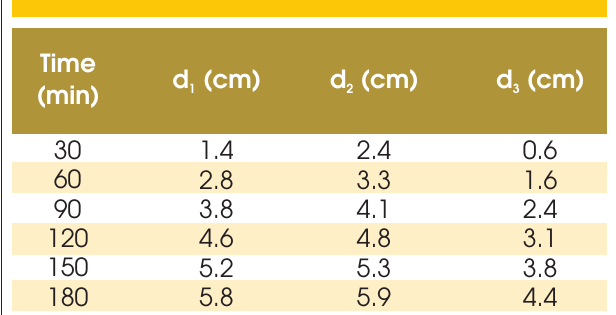
Figure 14 – Temperatures along the upper face of a slab with 8 cm block and 4 cm